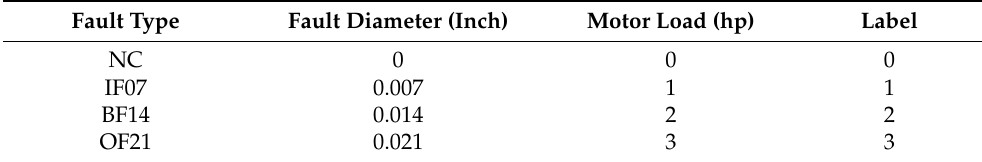
Table 5. Composition of bearing fault data under variable working conditions (Dataset